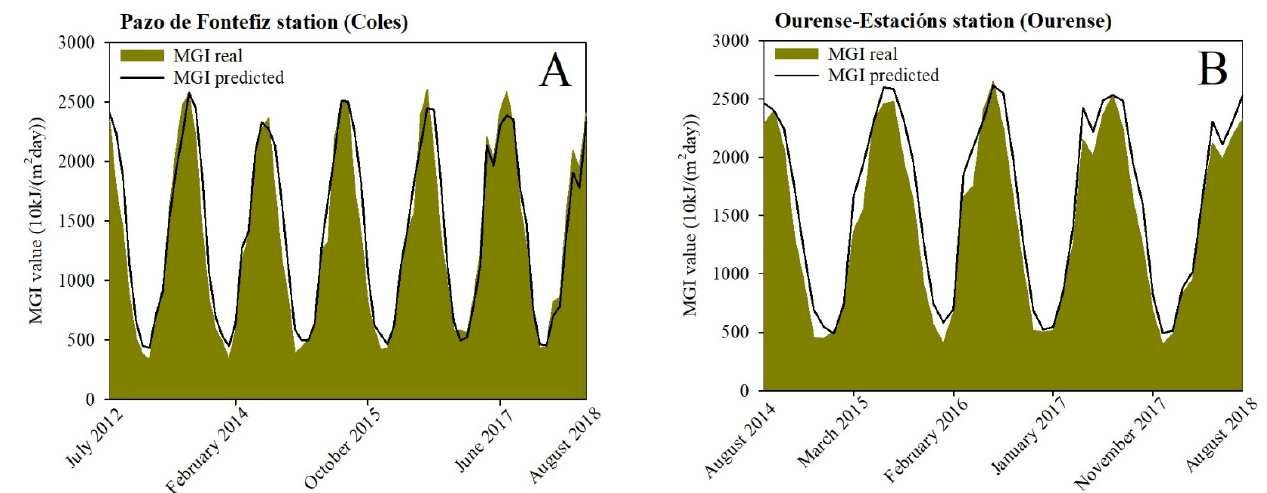
Figure 3. Real and modelled time series for ( A ) Pazo de Fontefiz and ( B ) Ourense-Estacións stations. The olive shade corresponds to the actual values, and the black line corresponds to the values modelled by the ANN model.